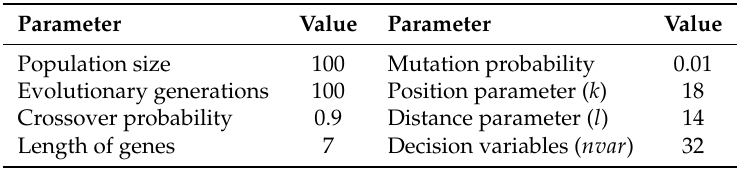
Table 4. Parameter settings of